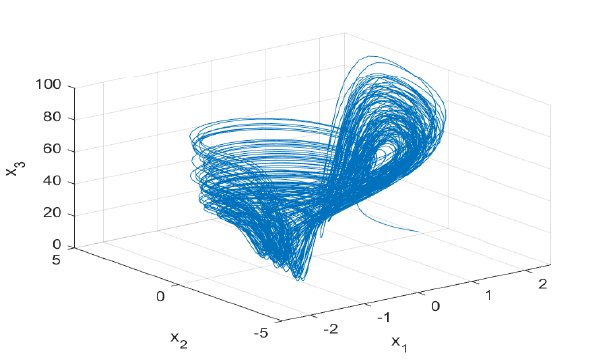
Figure 10. Phase portraits of system (1) for a = 10, c = 8/3, d = 0.1 and b = 10.